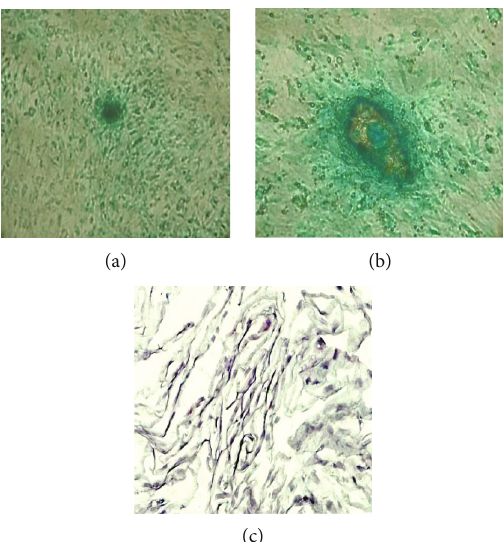
Figure 3: AT-MSC chondrocyte-like cells at 14 days: (a) Alcian Blue magni fi cation × 10; (b) Alcian Blue magni fi cation × 40; (c) H-E stain of chondrocytes magni fi cation × 20.